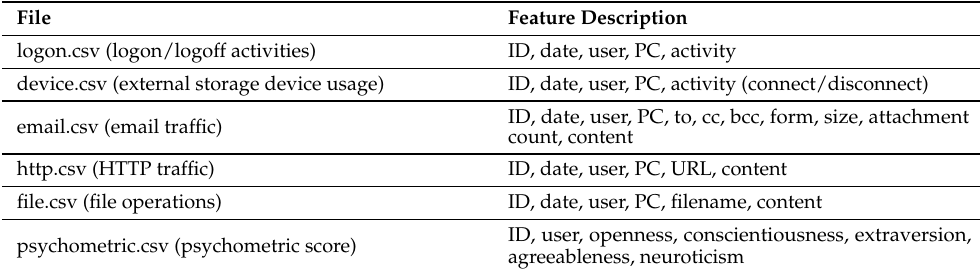
Table 3. Dataset files and